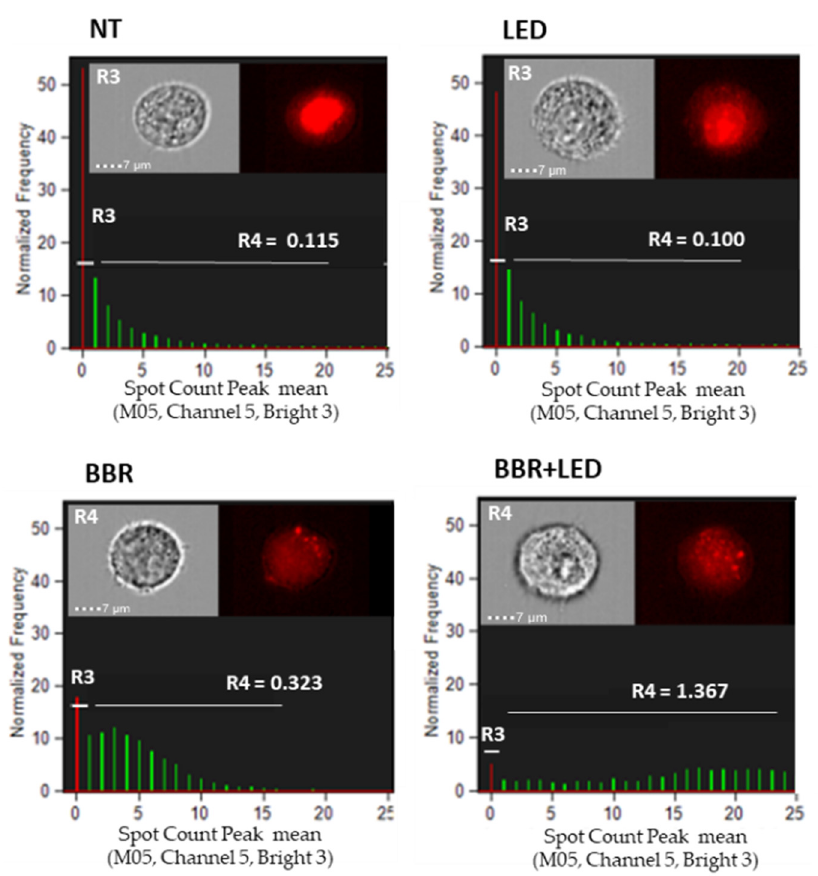
Figure 6. Nuclear fragmentation analysis. Amnis ImageStream MkII flow cytometry analysis of nuclear fragmentation in T98G cells as untreated (NT), exposed to LED stimulation (LED), BBR (200 µ g/mL for 4 h) administration and with the combined scheme (BBR + LED), evaluated after 24 h p.t. Trypsinized cells were analyzed for bright field (Ch04) and for nuclear fluorescence (Ch05) using DRAQ5 dye (Invitrogen) at 60 × magnification. R3 and R4 gates indicated integrity and nuclear fragmentation signals, respectively. Mean Spot Count Peak values (i.e., 0.323 and 1.367) and cell images representative of R3 and R4 gates are reported. R1 and R2 gates (not shown) identified focused cells.